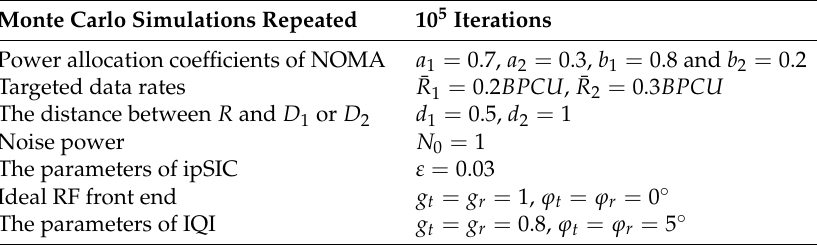
Table 2. Table of parameters used for numerical results.